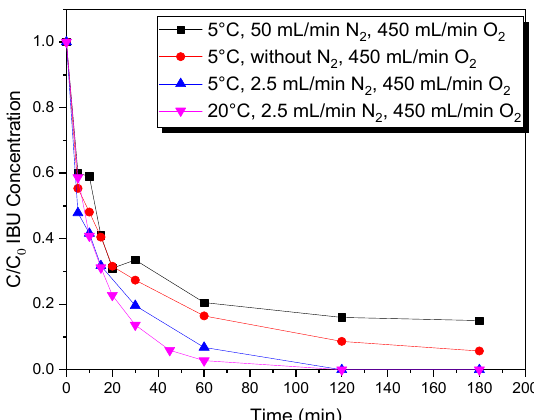
Figure 4. The degradation of Ibuprofen [2-(4-isobutyl phenyl) propionic acid] (IBU) by ozonation in absence of catalyst. [IBU] = 10 mg/L, gas flow rate = 450–500 mL/min, T = 20, 5 °C, stirring rate = 1070 rpm.